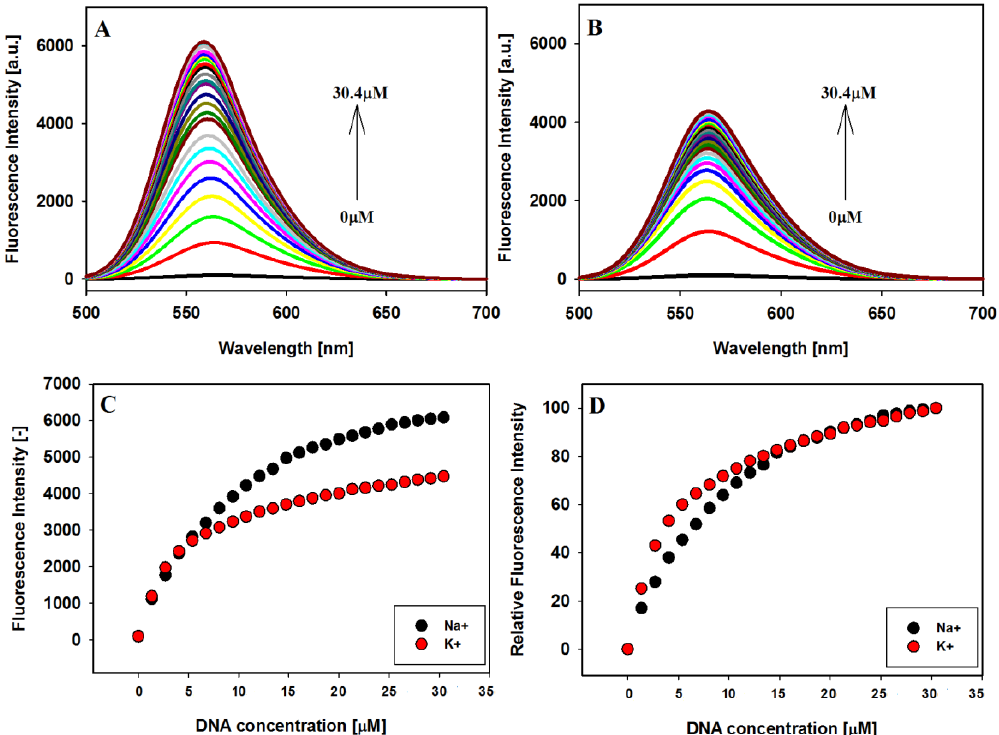
Figure 4. Fluorescence titration spectra of ligand 3 (2 µM) with G4 22HT in Tris-HCl buffer (10 mM, pH 7.2) containing 100 mM NaCl ( A ) and 150 mM KCl ( B ); fluorescence binding curves ( C ) and